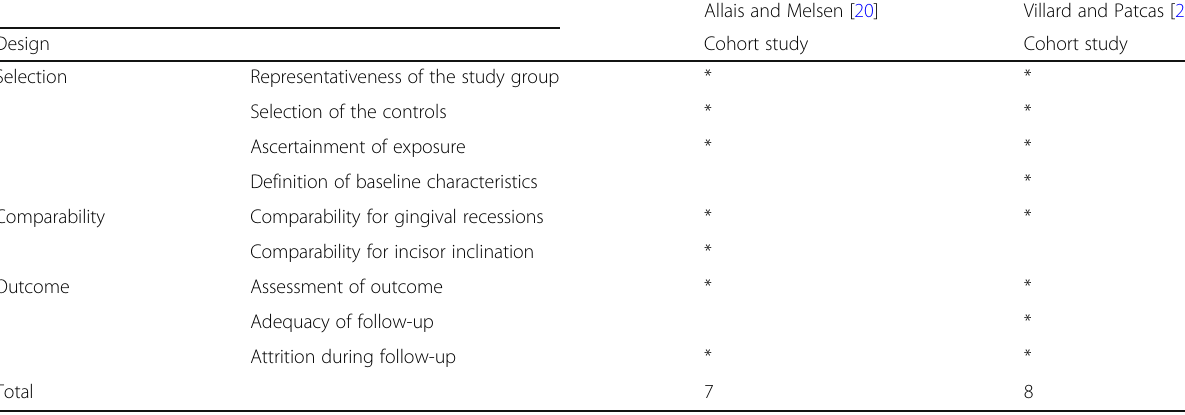
Table 2 Assessment of risk of bias of observational studies with the Newcastle-Ottawa